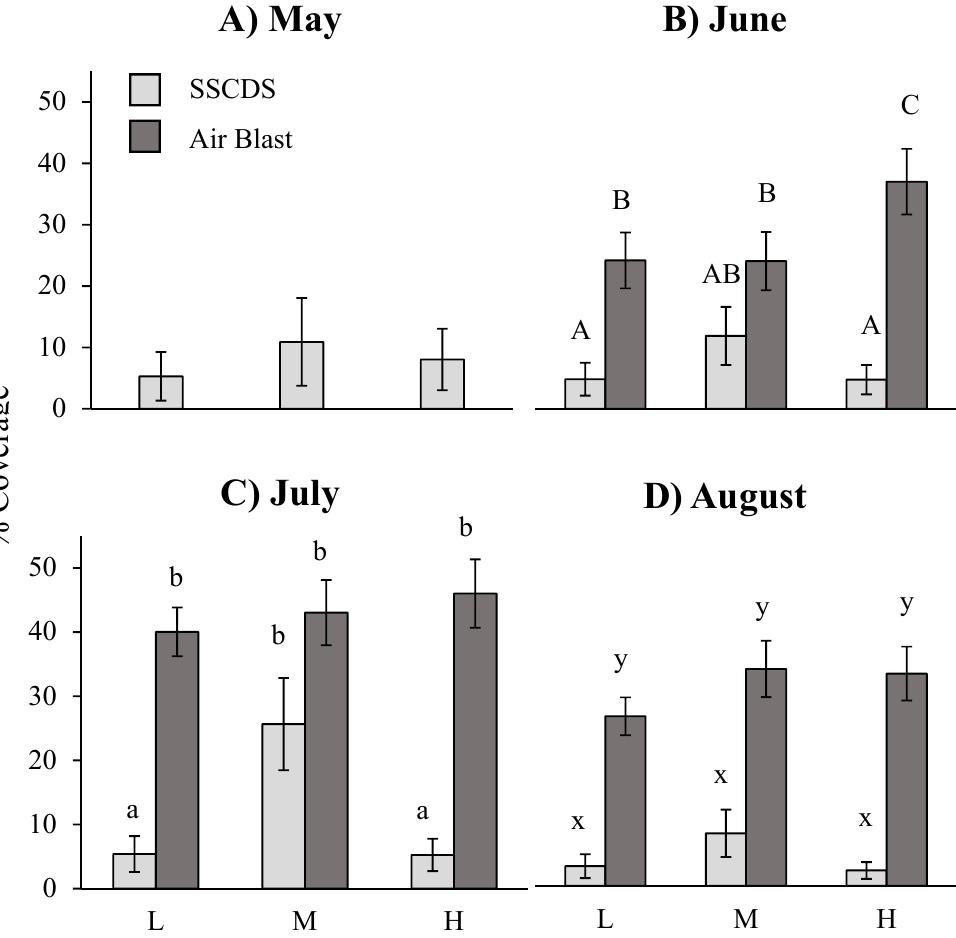
Figure 5. Least square means of the percent abaxial coverage (cm 2 ). Means shown for each of the sampled dates ( A ) 5 / 2 / 16, ( B ) 6 / 8 / 16, ( C ) 7 / 12 / 16, and ( D ) 8 / 8 / 16 and heights (L = 0.7 m, M = 1.4 m, H = 2.1 m). Error bars indicate (Tukey-Kramer) 95% confidence intervals. Different letters within a month indicate significant differences among bars within a month. No significant differences were detected in May (SSCDS system only).